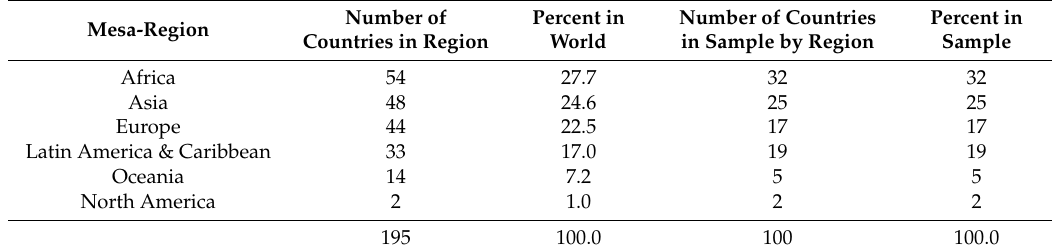
Table 2. Percentage of States by Region and in the Research Sample. Number of Percent in Number of Countries Mesa-Region Countries in Region World in Sample by Region